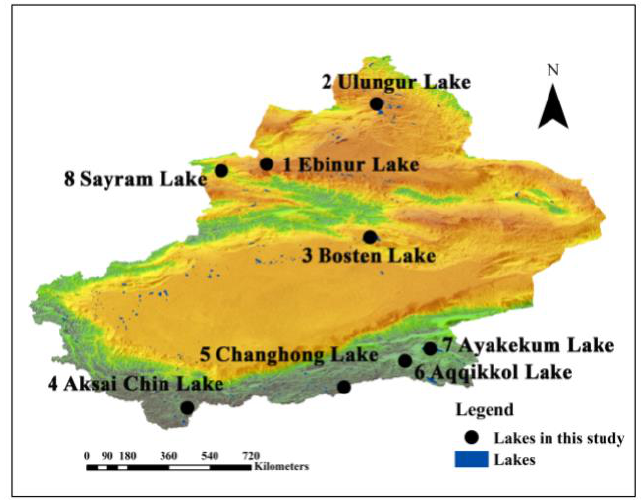
Figure 2. Geographic locations of study lakes.